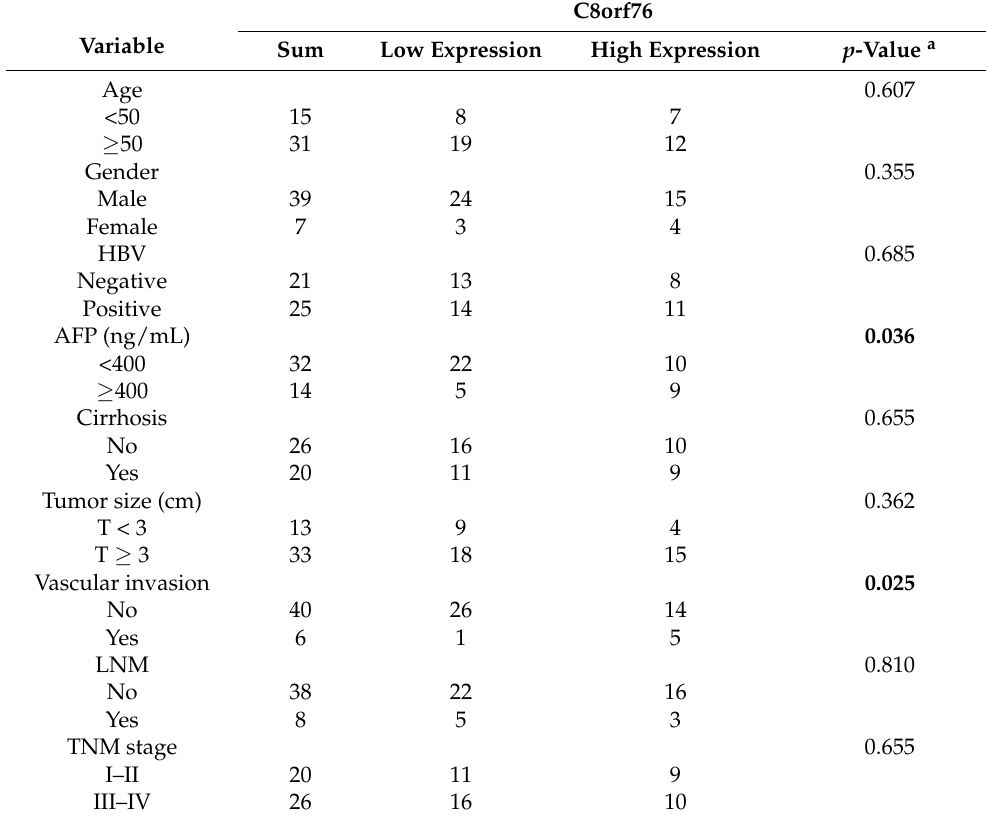
Table 1. Correlation of C8orf76 expression and clinical features in HCC